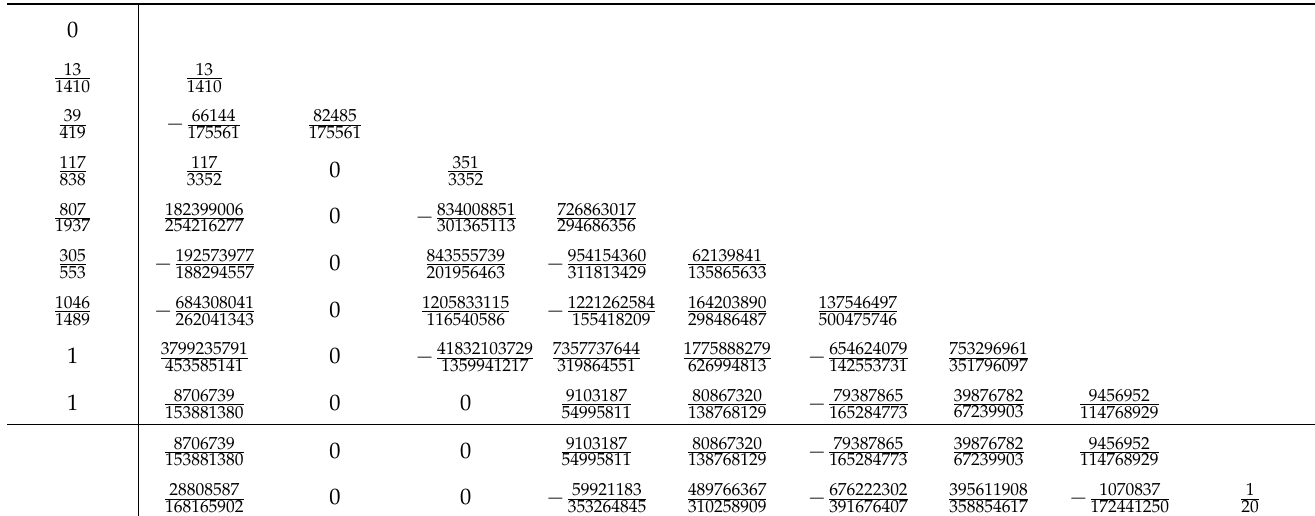
Table 1. Coefficients of the proposed here NEW6(5) pair, accurate for double precision